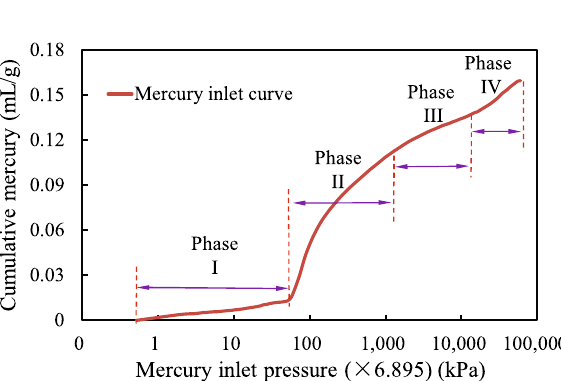
Figure 7. Relation between mercury inlet pressure and cumulative mercury (1 psi = 6.895 kPa).